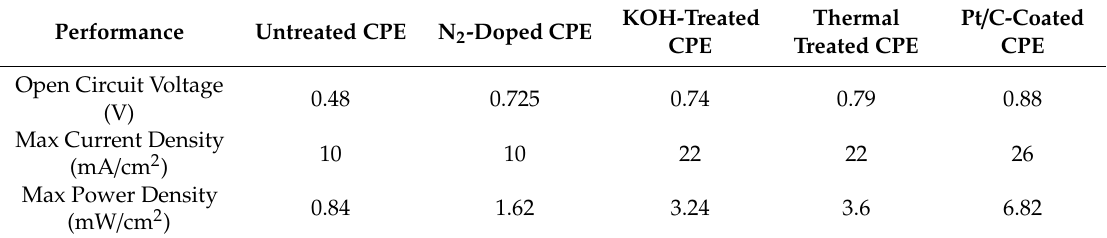
Table 1. Comparison of the open circuit voltage, maximum current density, and maximum power density for cells consisting of five di ff erent carbon porous electrodes as cathode